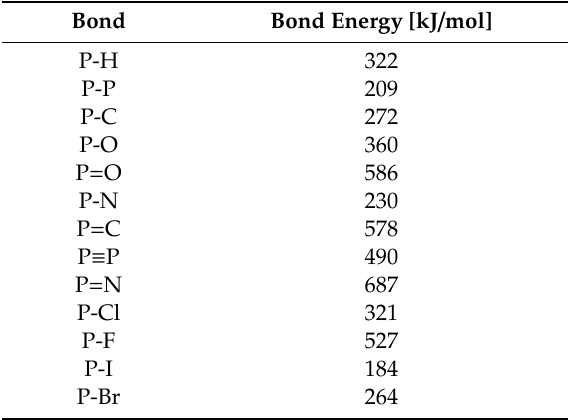
Table 1. Bond energies of chosen phosphorus-containing linkages